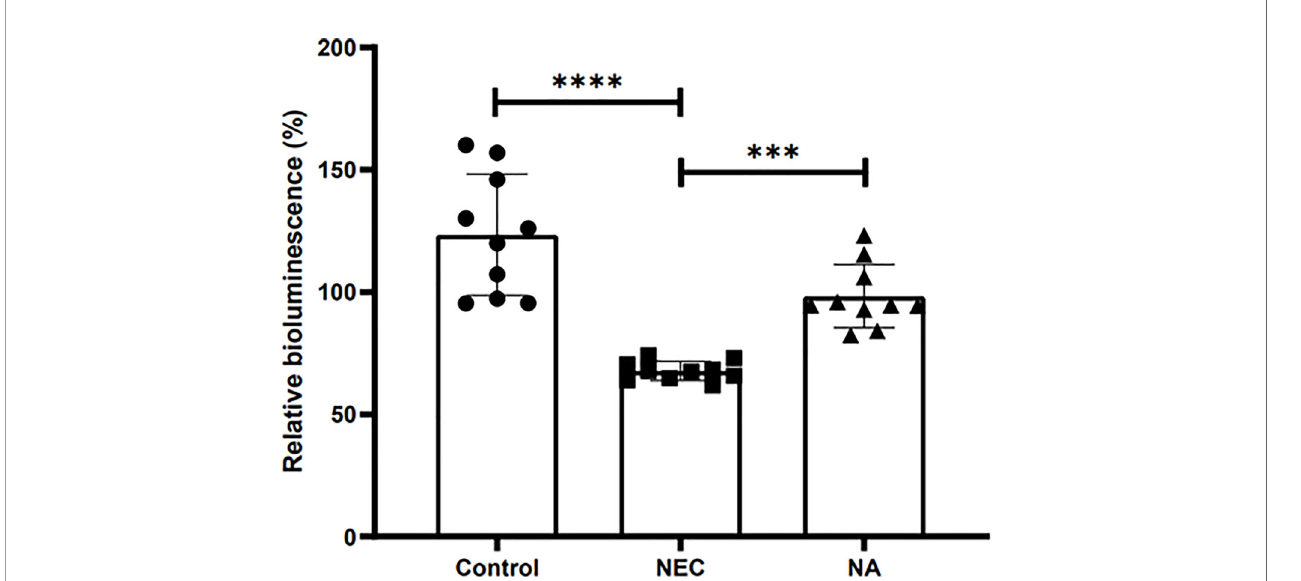
FIGURE 3 | The relative bioluminescence values in the mouse stools of AI-2 in the three groups of newborn mice. Numbers of samples: Con (n=10), NEC (n=10), and NA (n=10). Statistics: one-way ANOVA (***p < 0.001; ****P <